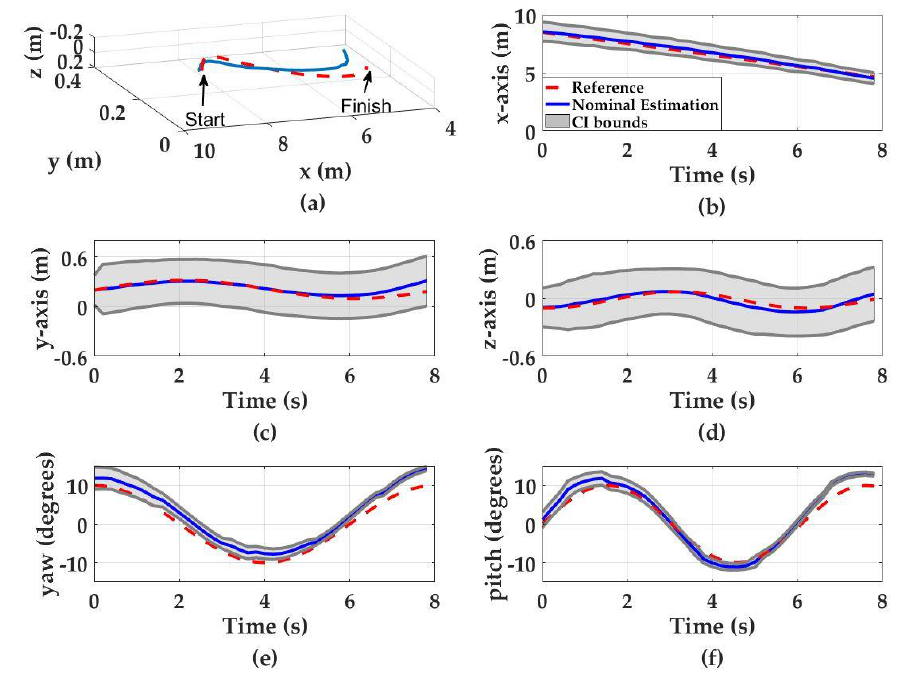
Figure 7. Monte Carlo simulation results for three-dimensional zigzag motion. Red dashed curves denote the UUV motion, blue curves denote the nominal position estimations and the gray regions denote the 95% confidence interval. ( a ) The UUV trajectory in zigzag motion (3D space); ( b ) x -axis estimations; ( c ) y -axis estimations; ( d ) z -axis estimations; ( e ) yaw estimations; and ( f ) pitch estimations.